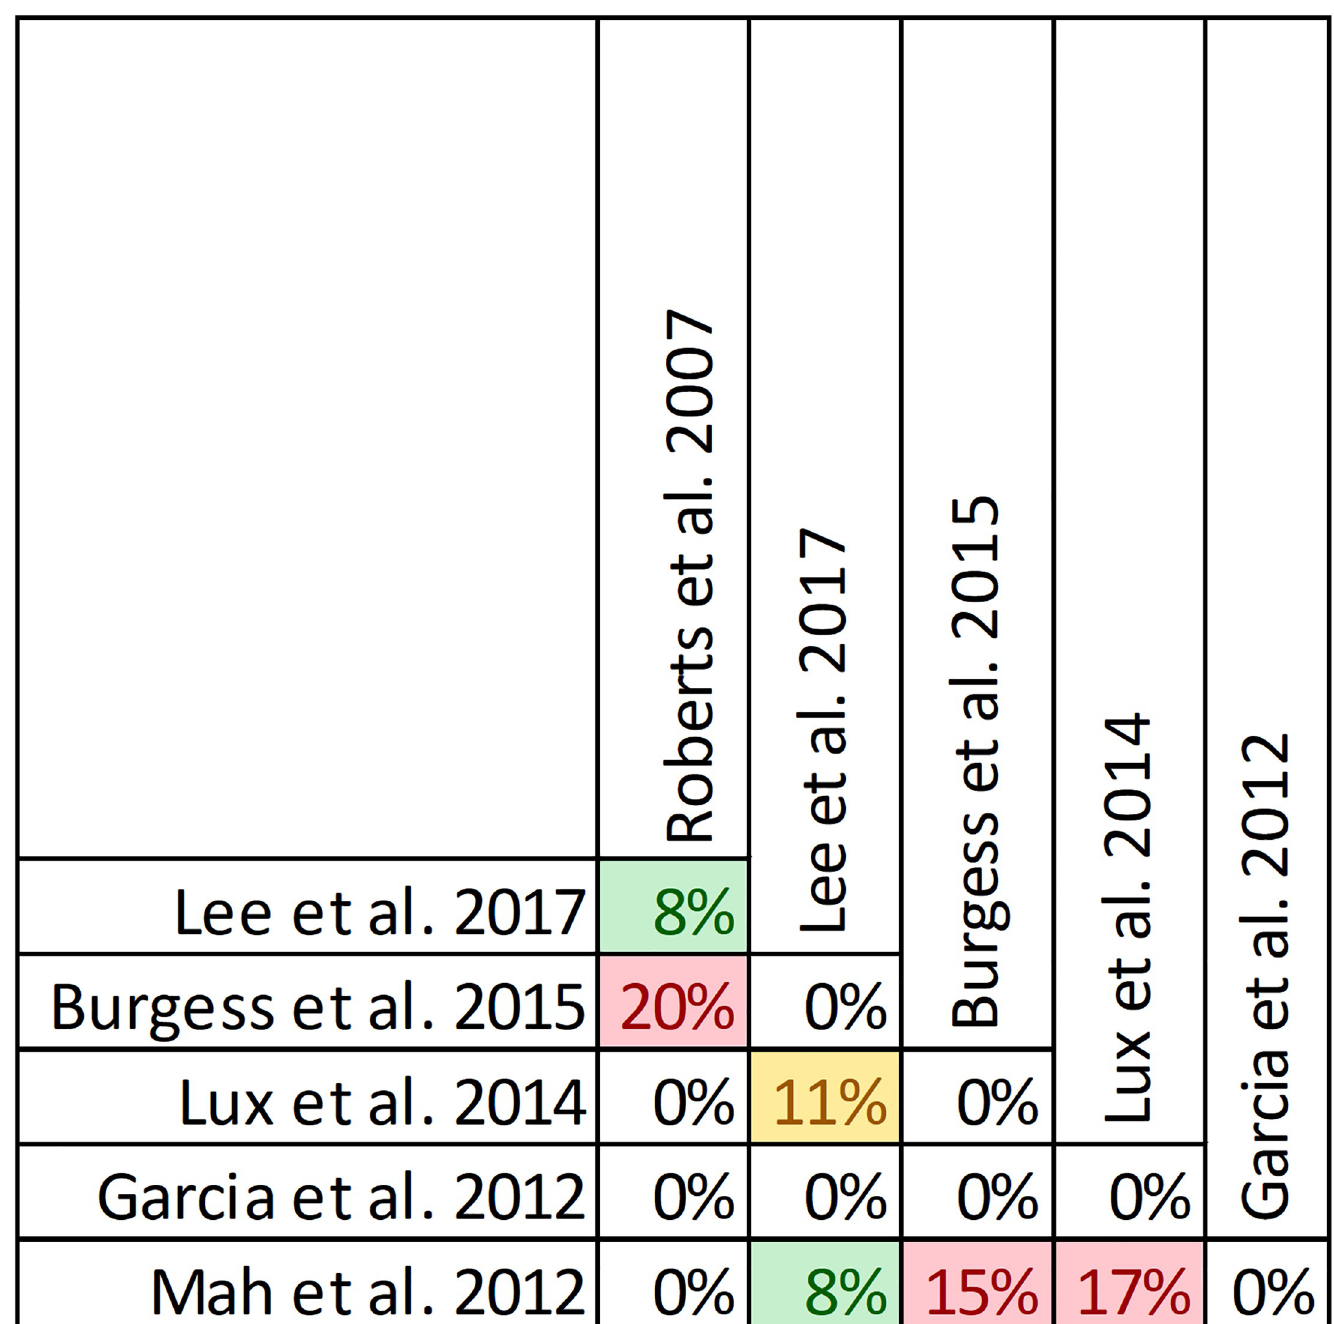
Fig 21. Pairwise CCA for reviews reporting PK/PD outcomes of prolonged versus intermittent infusion of beta-lactams. Colors indicate degree of overlap, as calculated with CCA, for visual clarity. White = � 5%, green 5.1–9.9%, yellow 10–14.9%, red � 15%. N/A indicated where primary studies included were not reported by systematic